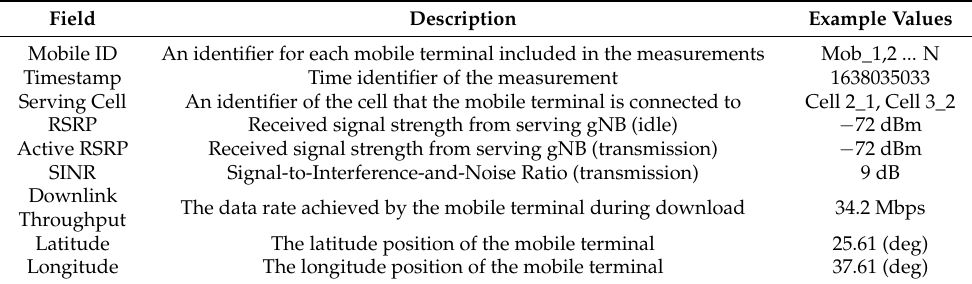
Table 3. Mobile Terminal simulation measurement dataset analysis.